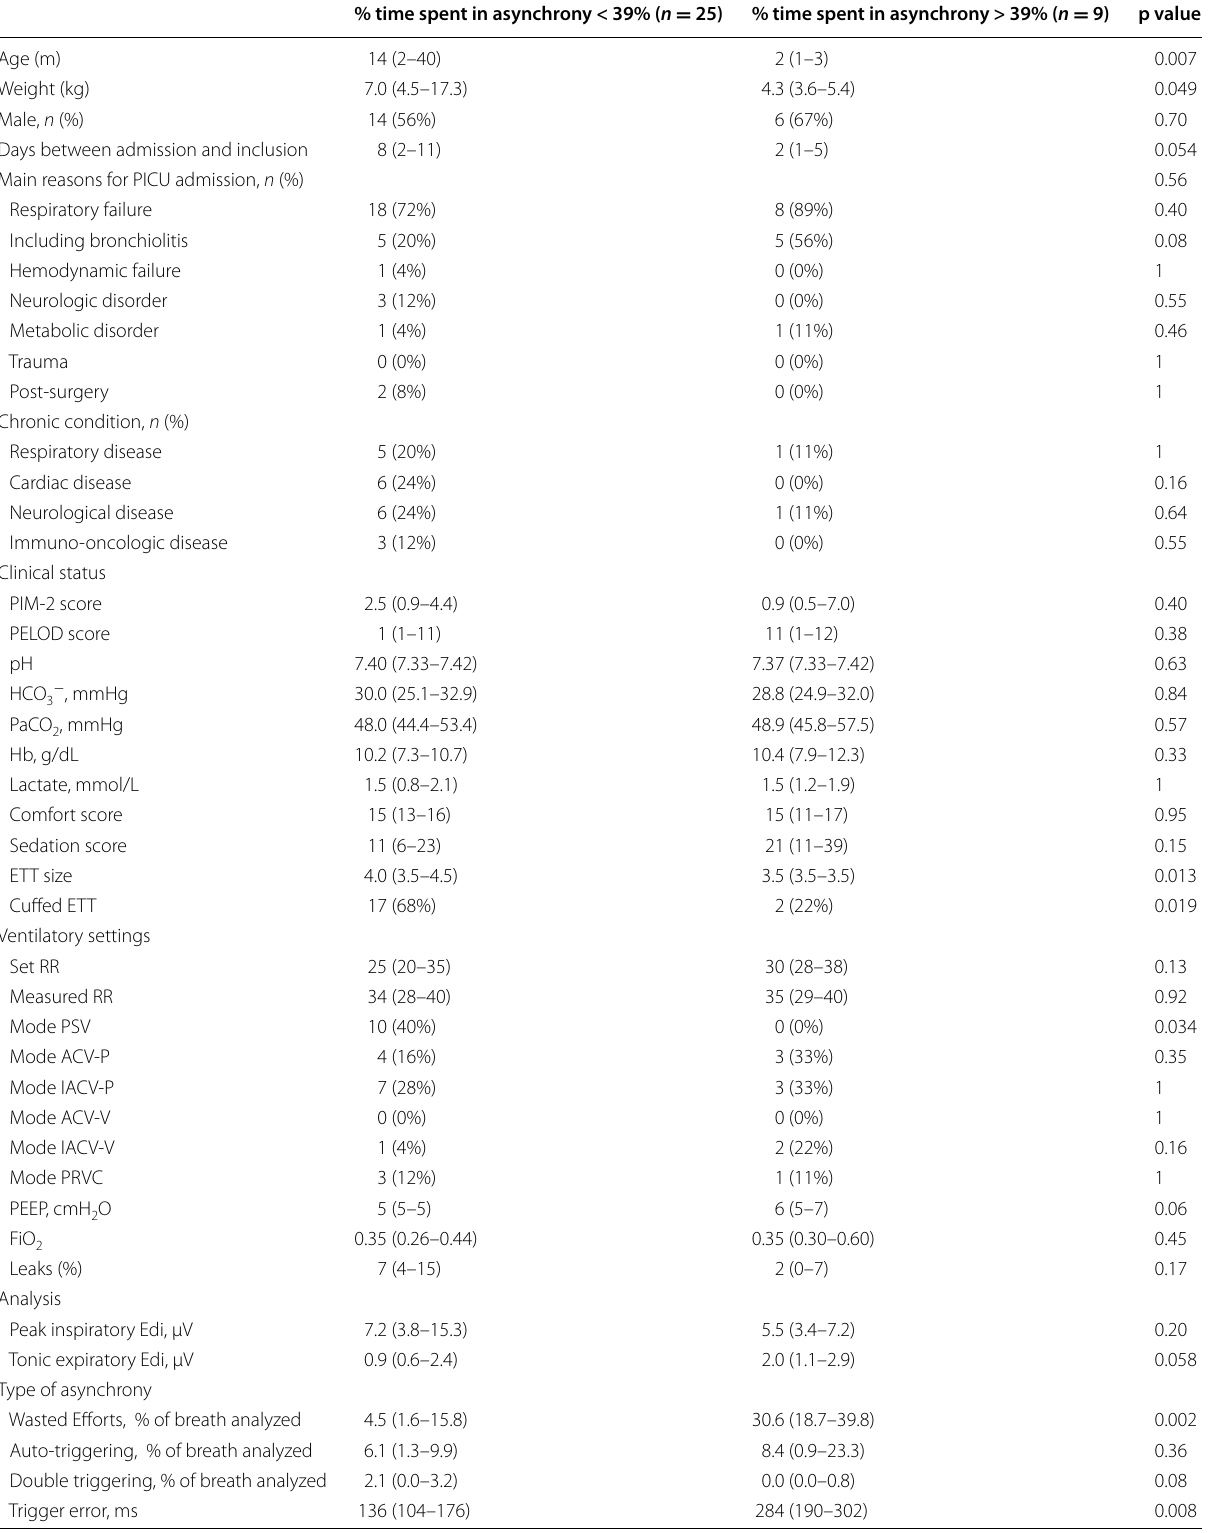
Table 2 Characteristics of patients depending on the level of asynchrony (in patients with Edi > 2 µV, n